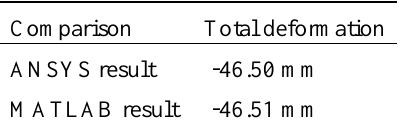
Comparison between approximate and exact solution